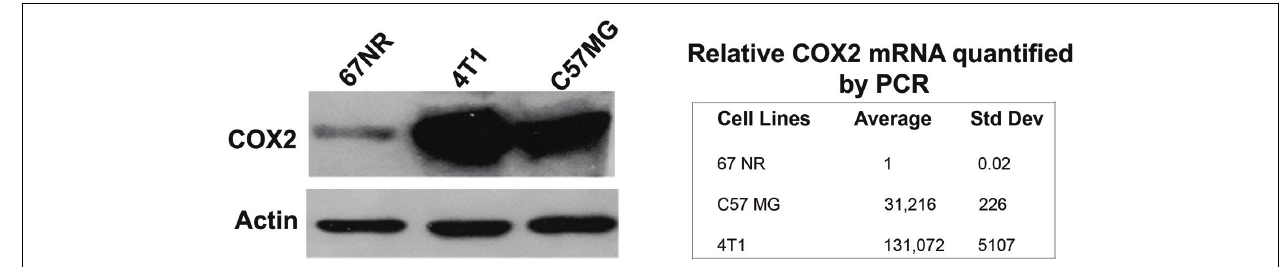
FIGURE 3 |Analysis of COX2 expression and quantity in murine breast cancer cells. Western blot analysis was performed to verify the presence and relative intensity of COX2 in C57GM cells compared to other cells. β -actin served as a loading control (left). RT-PCR data were used to quantify the level of COX2 expression after normalization.